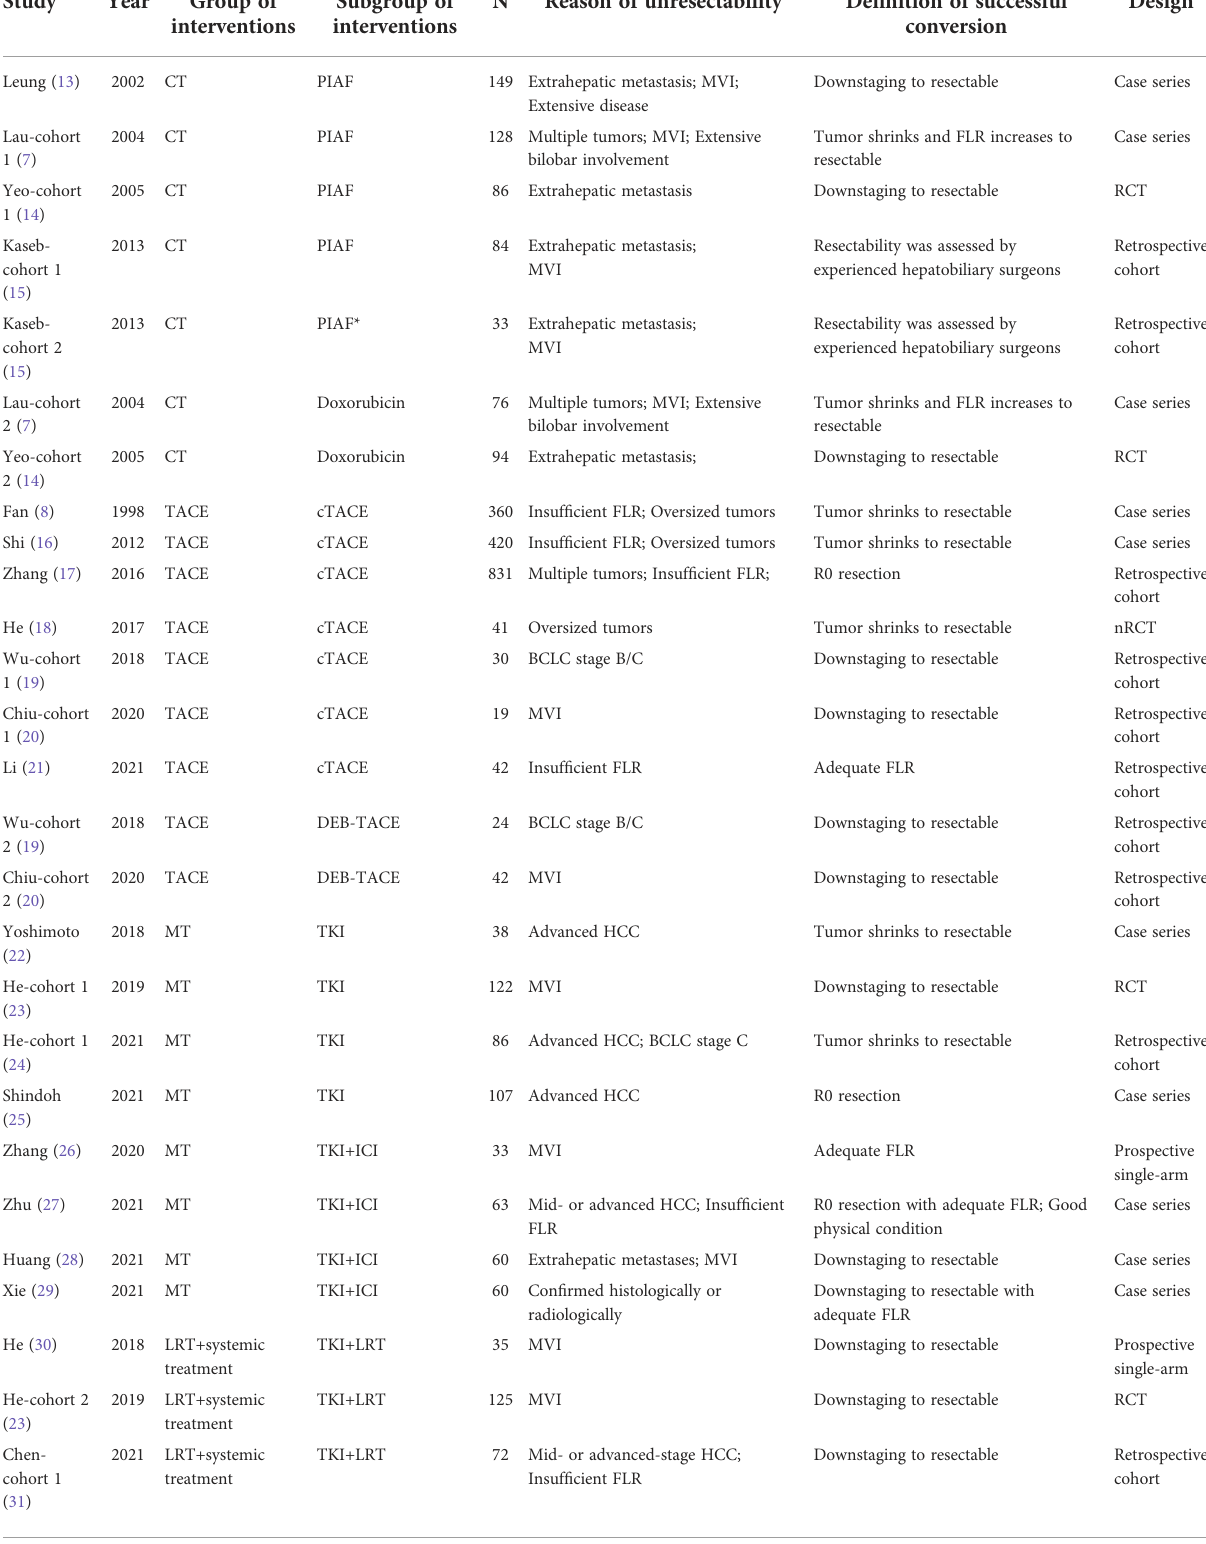
TABLE 1 Characteristics of included